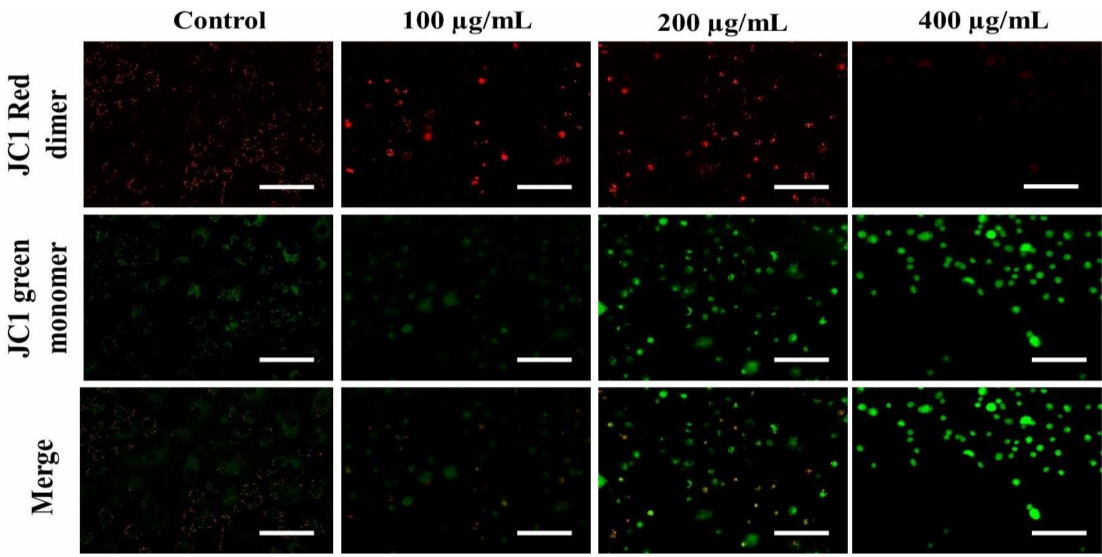
Figure 8. Fluorescent photomicrographs depicting the dissipation of ∆Ψ m within JC-1-stained A549 cells post AvL -EtOH exposure at concentrations of 100–400 µ g/mL. Scale bar = 100 µ